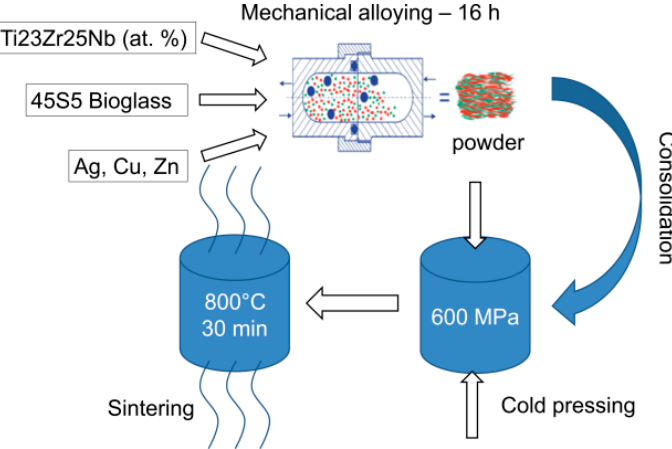
Figure 1. Schematics representation of the mechanism behind the mechanical alloying of biocomposites.